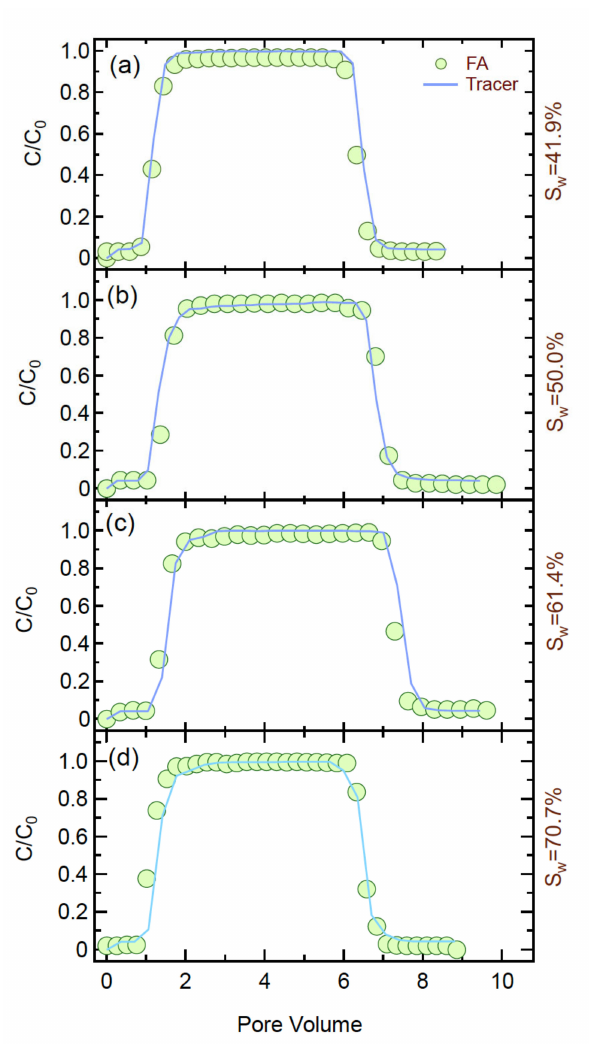
Figure 2. Breakthrough data from the transport experiments with FA and tracer in unsaturated columns packed with sand under various flow rates: ( a ) 1, ( b ) 1.5, ( c ) 2, and ( d ) 3 mL /